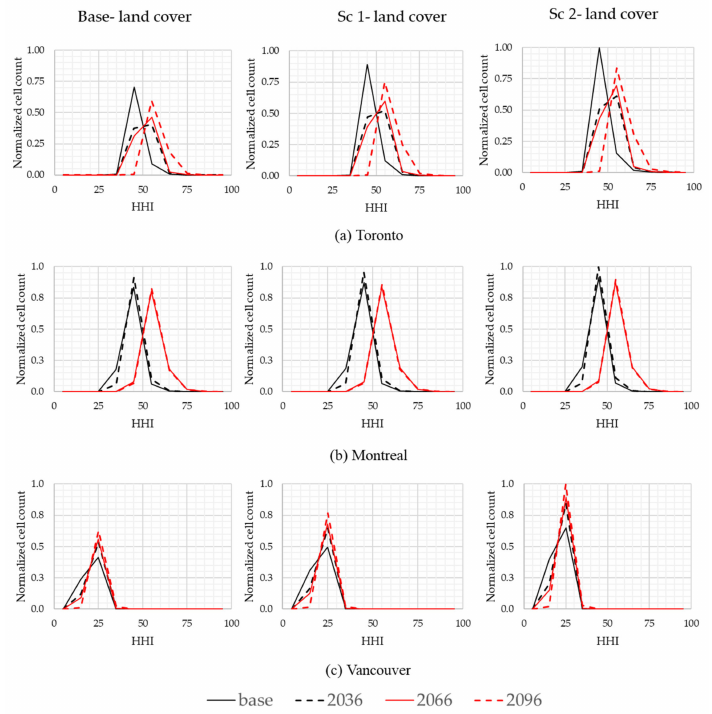
Figure 8. Normalized histograms of HHI (to the maximum HHI frequency of the cities) comparing the same urbanization scenarios (base, Scenario 1, and Scenario 2) and di ff erent Climate scenarios (base, 2036, 2066, and 2096) for: ( a ) Toronto; ( b ) Montreal; and ( c )